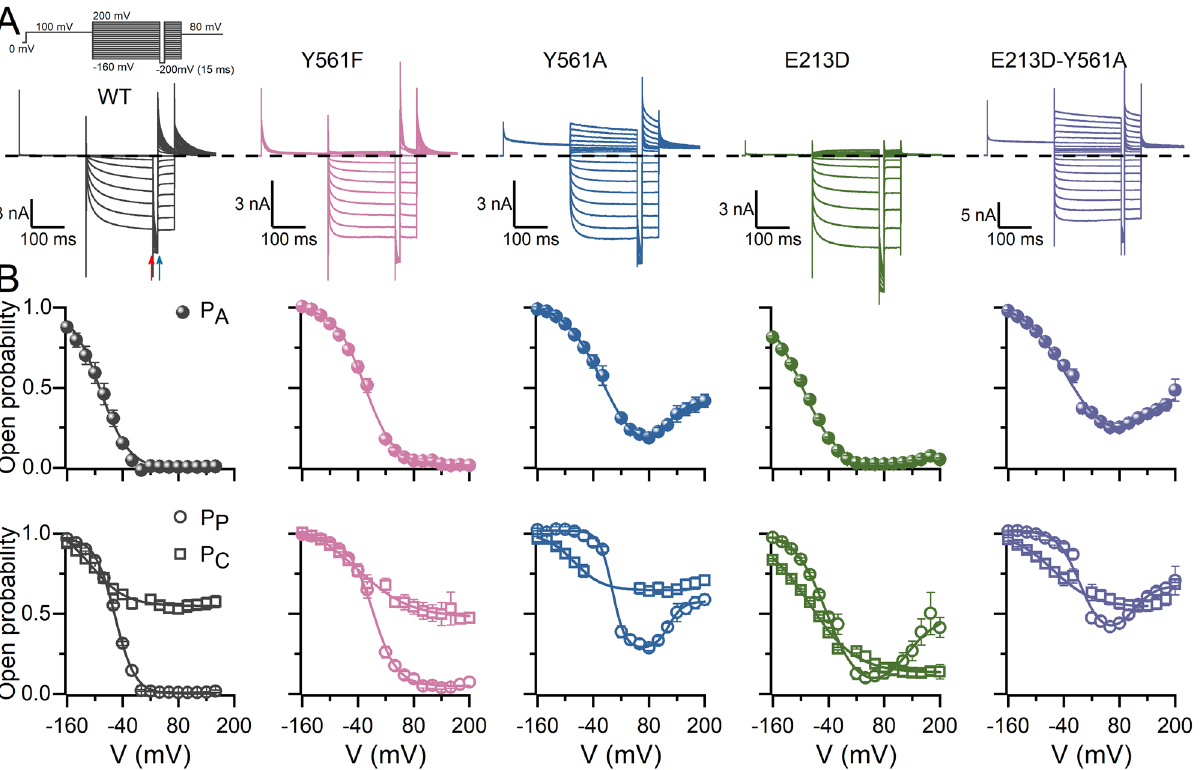
Figure 2. Voltage-dependent activation of CLC-2 depends on both Y561 and E213. (A) Colour coded Cl − currents recorded from five different HEK293 cells expressing WT CLC-2, Y561F, Y561A, E213D, and E213D-Y561A channels. Cl − currents were elicited by the voltage protocol shown in the upper left corner. The protocol consisted of voltage steps from − 160 or − 200 to + 200 mV in 20 mV increments and a repolarization voltage to + 80 mV to record tail currents. We intercalated a 15 ms/− 200 mV step and used the magnitude of the currents measured before and after the interpulse (red and blue arrows, respectively) to calculate the open probability of pore (P P ) and common (P C ) gates (see methods). Cl − currents were recorded using pH i = pH o = 7.3 and [Cl − ] i = [Cl − ] o = 140 mM. (B) The voltage dependency of the apparent open probability (P A , spheres), pore (P P , circles) and common (P C , squares) gates computed for WT CLC-2, Y561F, Y561A, E213D, and E213D- Y561A channels. Upper row: P A ; lower row: P P and P C . Continuous lines are fits with a single (P A of WT, Y561F, and E213D; P P of WT and Y561F; P C of all channels) or double (P A of Y561A and E213D-Y561A; P P of Y561A, E213D, and E213D-Y561A) Boltzmann equation to determine voltage-dependent parameters V 0.5 and z listed